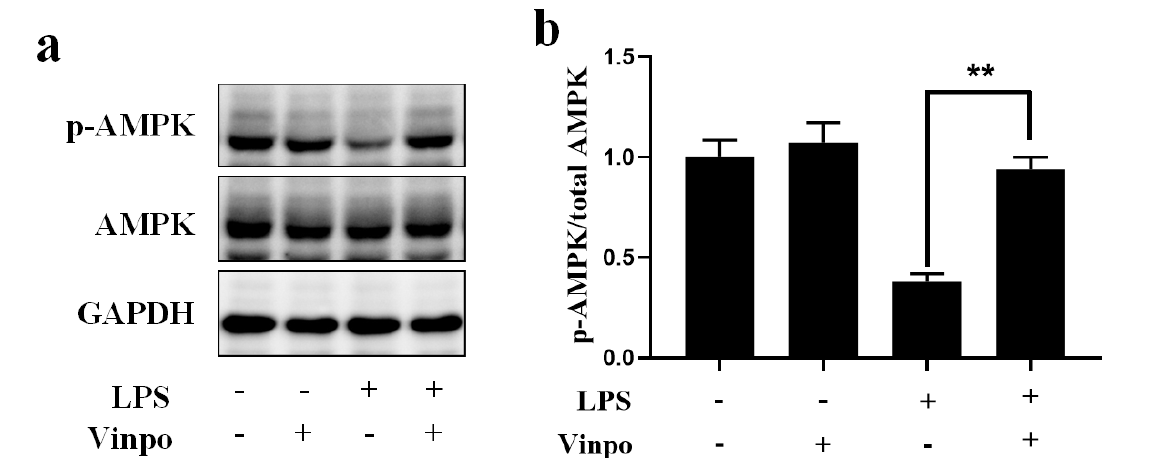
Figure 4. Vinpocetine suppressed LPS-induced inflammatory cytokine release in BV2 microglia via AMPK phosphorylation. (a) BV2 microglia were incubated with vinpocetine (50 μ M) for 23 h and then exposed to LPS (100 ng/mL) for 1 h. The phosphorylation of AMPK and total AMPK were determined by western blot analysis. GAPDH was used as a loading control. (b) The relative band intensity phosphorylated AMPK to total AMPK were analyzed. Data are representative of three independent experiments. **P < 0.01 compared between the indicated